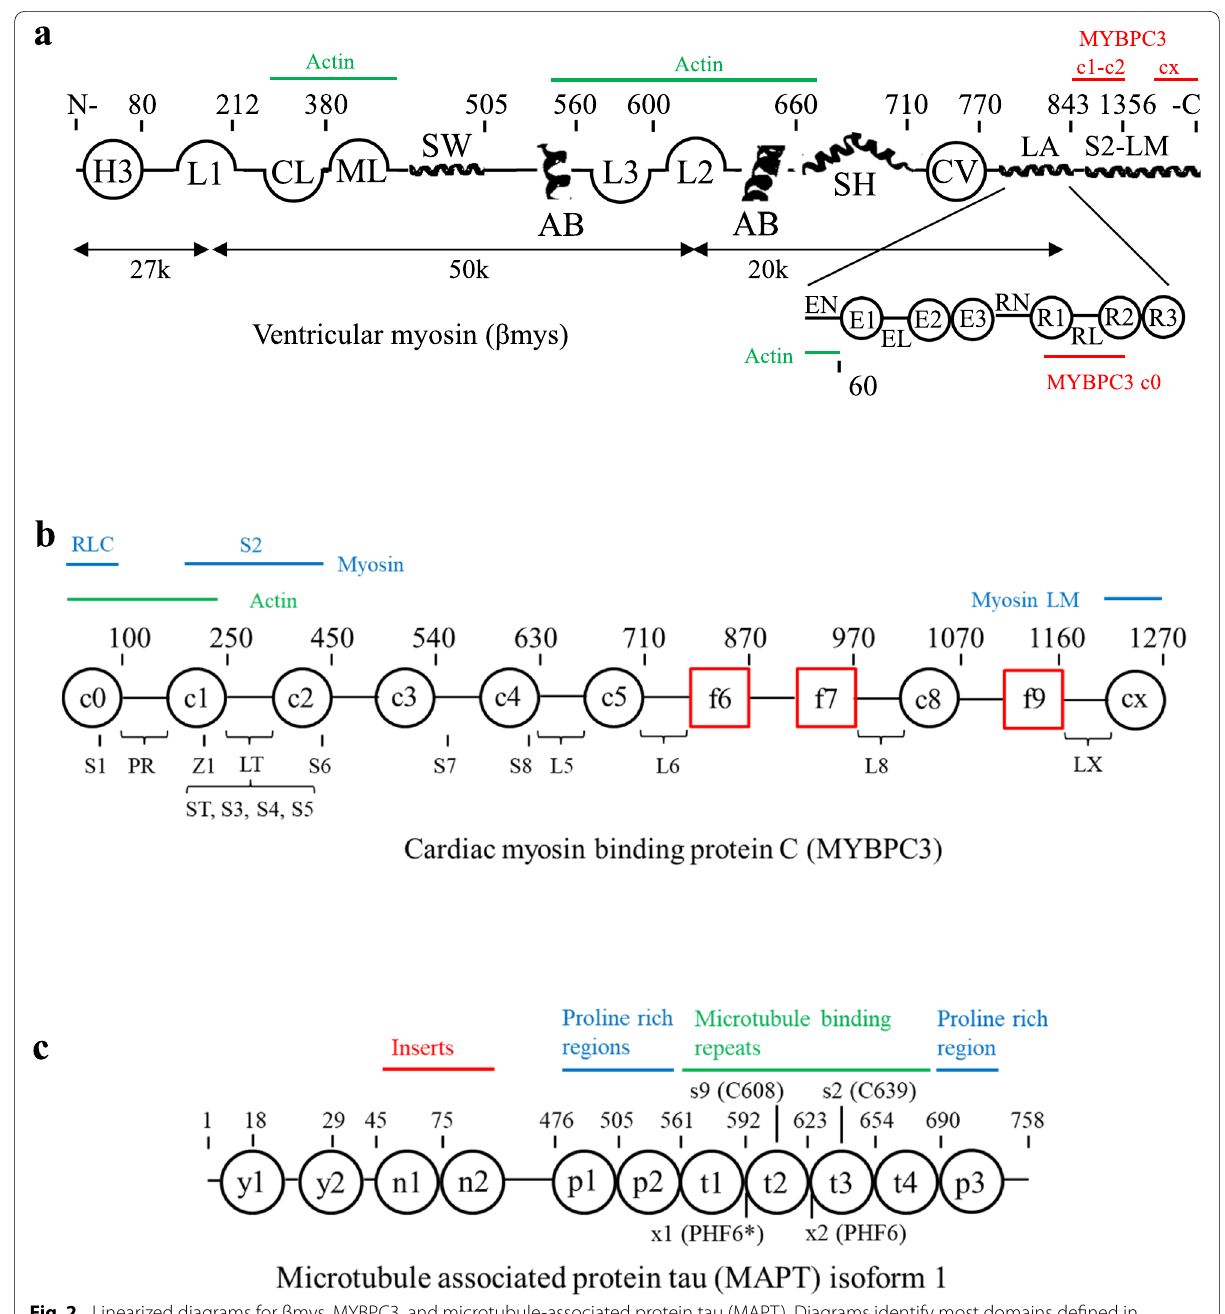
Fig. 2. Linearized diagrams for βmys, MYBPC3, and microtubule-associated protein tau (MAPT). Diagrams identify most domains defined in Supplementary Tables S1 and S4 and approximate residue numbering. a The βmys diagram has a heavy chain (H3 through LM), ELC (EN through E3), and RLC (RN through R3). Heavy chain diagram does not indicate the active site (AC), Omecamtiv Mecarbil binding site (OM), and mesa (ME) because they occupy multiple regions in the linear representation. MYBPC3 and actin binding sites are indicated in red and green above the heavy chain and below the light chains. b MYBPC3 has Ig-like (black circles) and fibronectin-like domains (red squares). Serine phosphorylation sites, S1 (Ser47), ST (Ser273), S3 (Ser282), S4 (Ser302), and S5-S7 and a threonine phosphorylation site (S8) are indicated below the chain. Domain linkers of interest include the proline rich linker (PR) and LT containing a regulatory site. Z1 is a zinc binding site. Myosin RLC, S2, LM, and actin binding sites on MYBPC3 are indicated above the linearized model. c The MAPT diagram shows the largest isoform (isoform 1). Sites or domains identified are tyrosine phosphorylation sites (y1 and y2), N-terminal inserts (n1 and n2), proline rich regions (p1-p3), microtubule binding repeats (t1-t4), cysteines C608 and C639 (s9 and s2), and hexapeptide motifs PHF6* (VQIINK at x1) and PHF6 (VQIVYK at